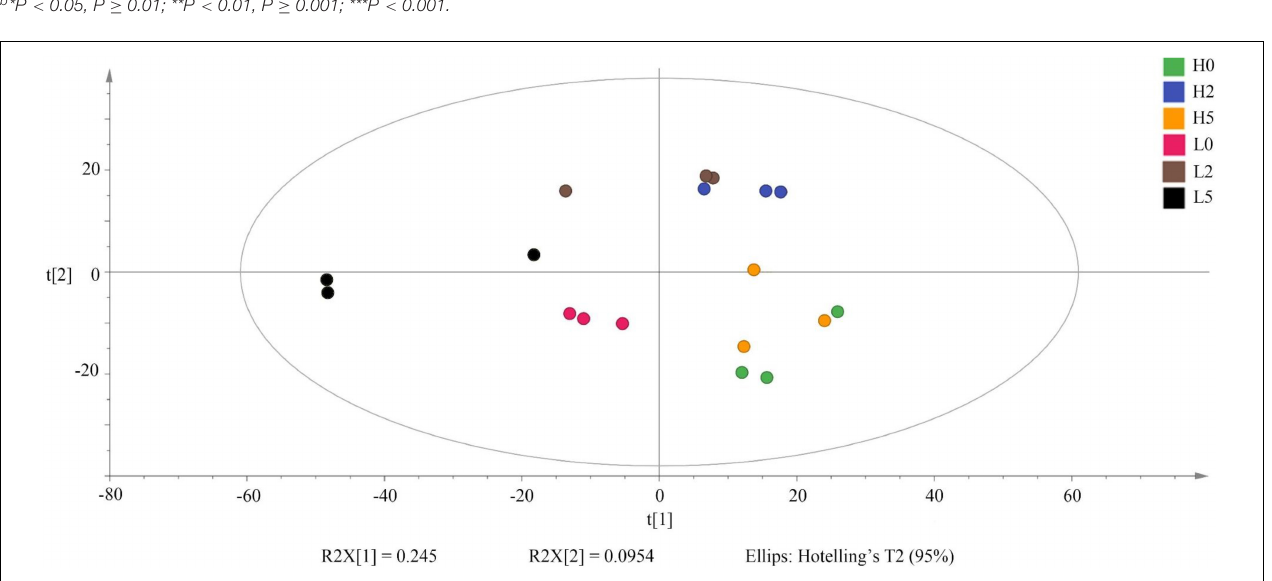
Saccharomycetaceae , unclassified Saccharomycetales , C. glabrata